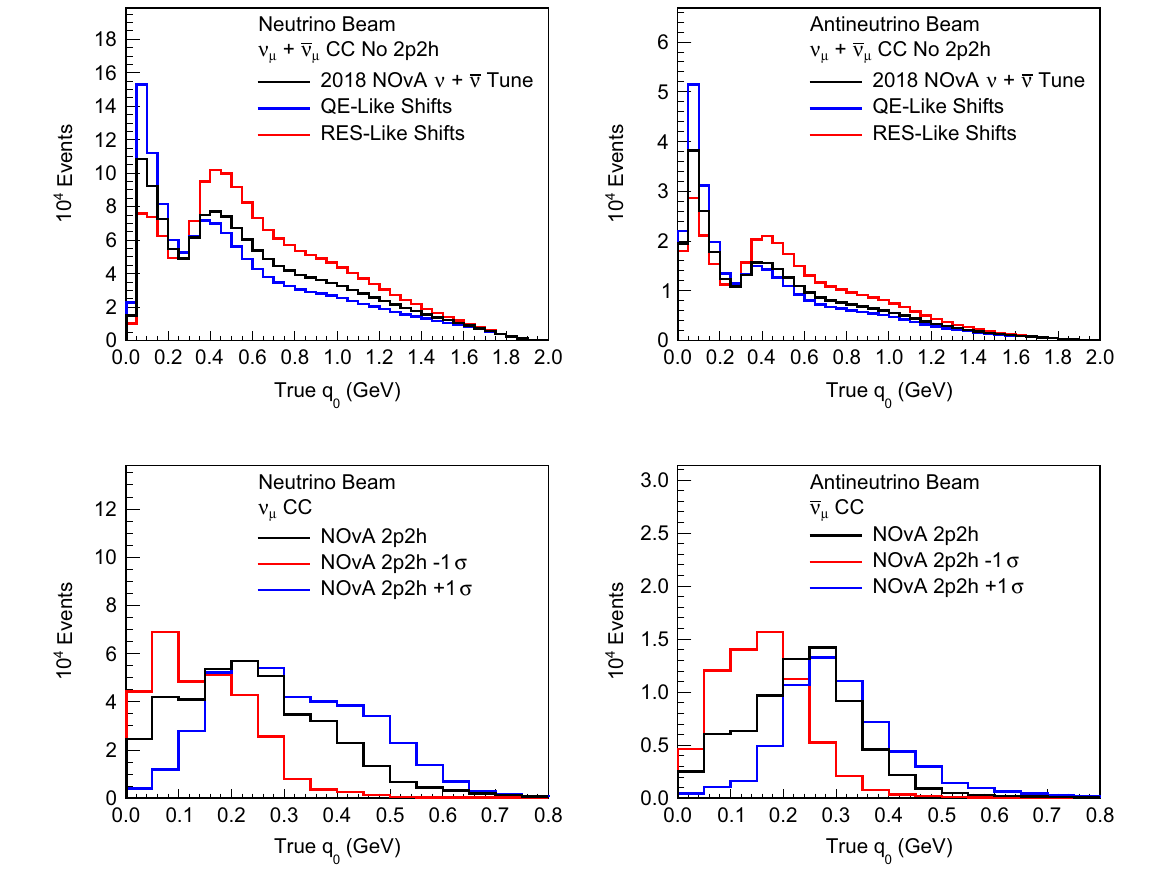
Fig. 11 True energy transfer distributions showing the result of shift- ing the fully-adjusted non-2p2h prediction to make it more QE-like or RES-like(toprow;neutrinomodeatleft,antineutrinomodeatright)and